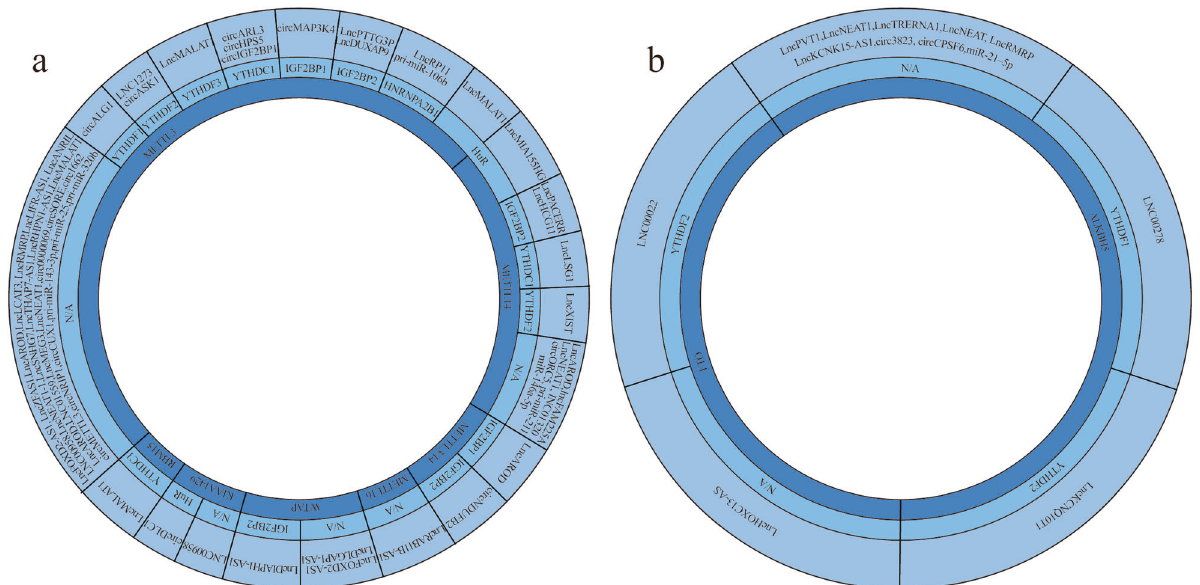
Fig. 2 ncRNAs regulated by writers, erasers, and readers in different cancers. ncRNAs are modi fi ed by writer proteins and recognized by reader proteins ( a ). ncRNAs targeted by eraser proteins and recognized by reader proteins ( b